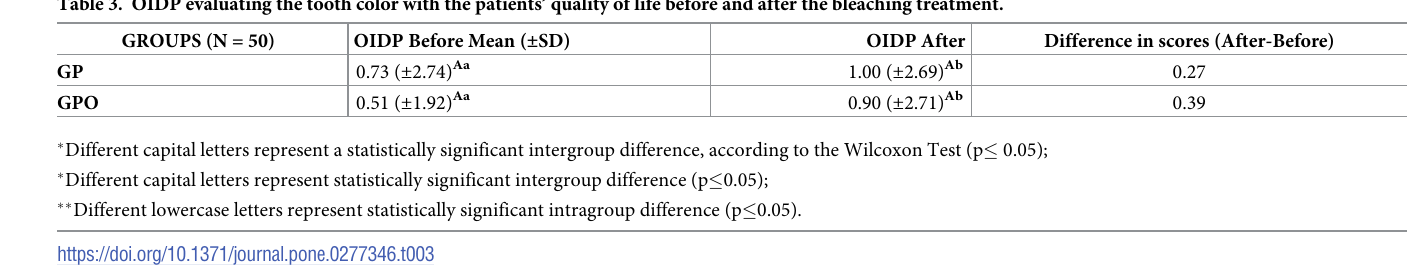
Table 3. OIDP evaluating the tooth color with the patients’ quality of life before and after the bleaching treatment. GROUPS (N = 50)